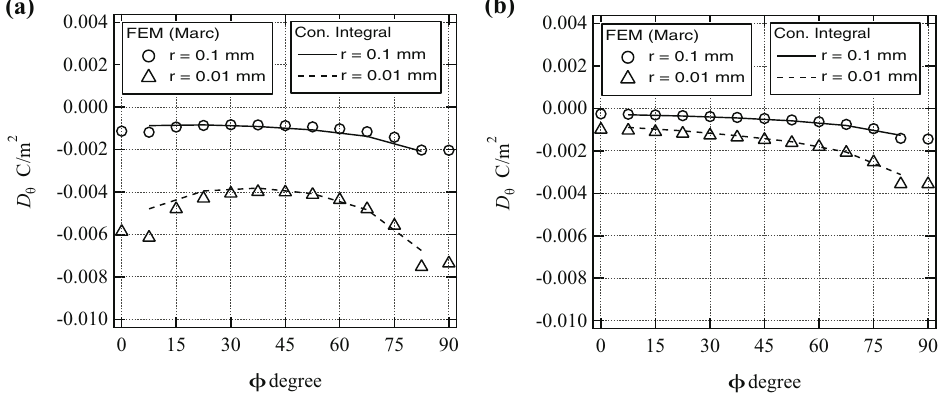
Figure 10: Distribution of electric displacements, D θ , at the interface, = θ 90° , with fi xed r at 0.01 and 0.1 mm: ( a ) Vertex - 1 and ( b ) Vertex - 2.